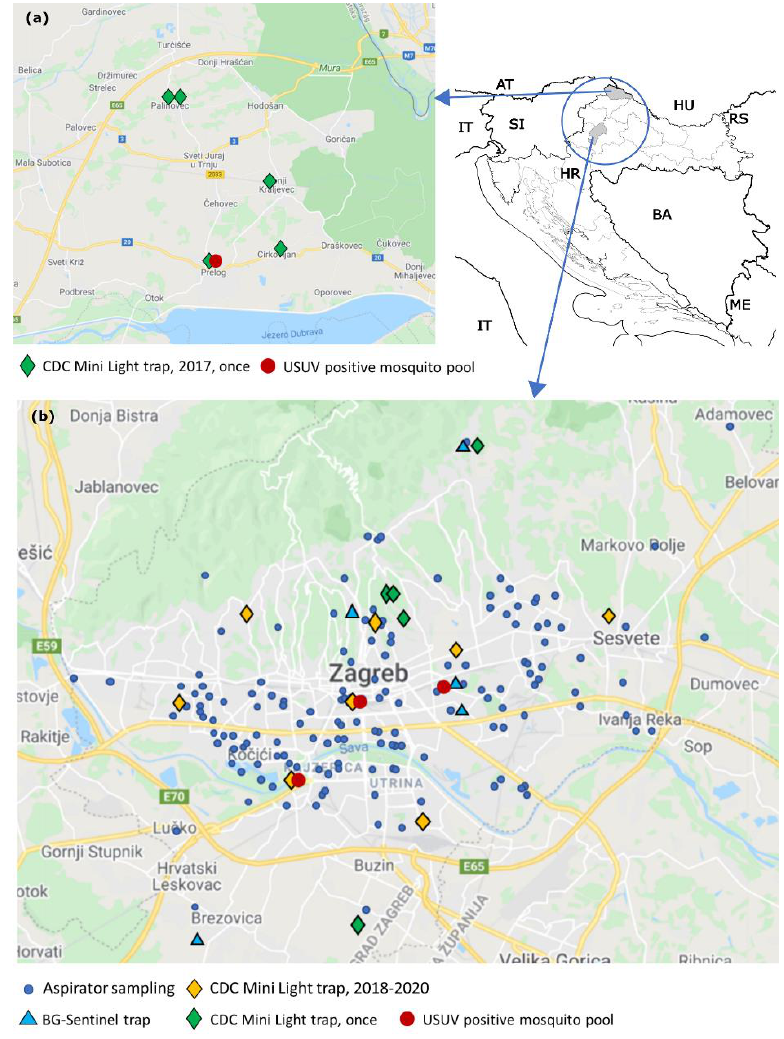
Figure 1. Distribution of mosquito sampling locations and Usutu virus (USUV) positive mosquito pools in northwestern Croatia, ( a ) Međimurje County, 2017; ( b ) City of Zagreb, 2015–2020.